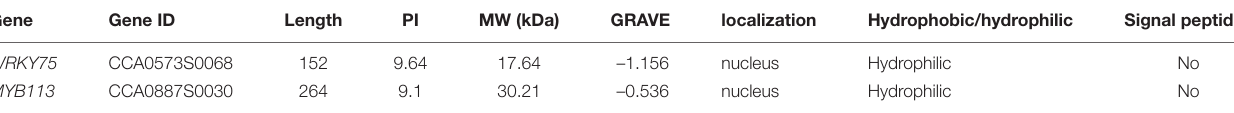
TABLE 1 | Physicochemical properties of proteins of WRKY75 and MYB113 in hickory.